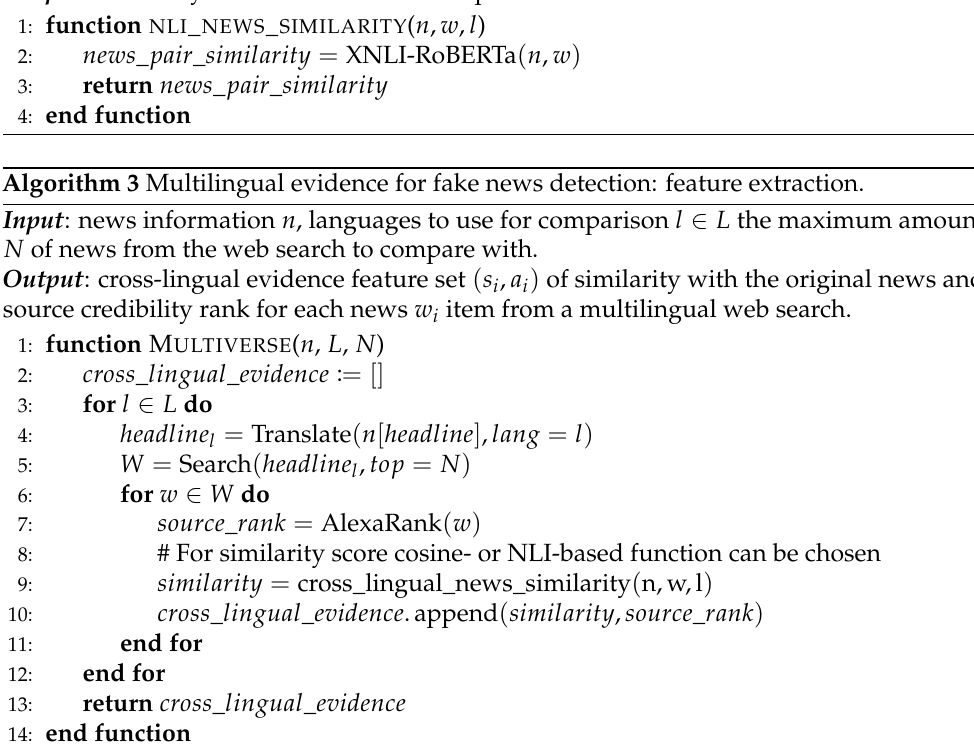
Algorithm 2 News similarity evaluation using NLI.